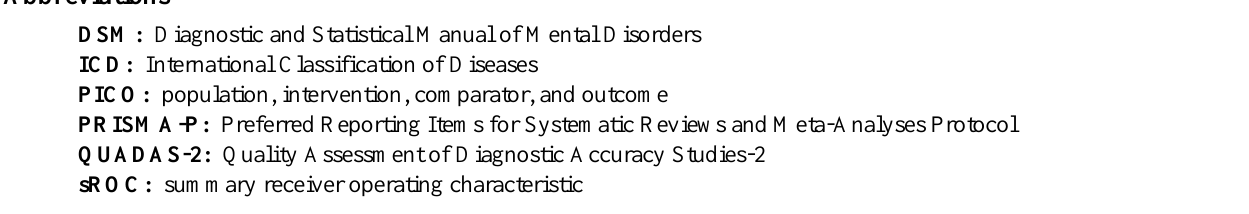
QUADAS-2: Quality Assessment of Diagnostic Accuracy